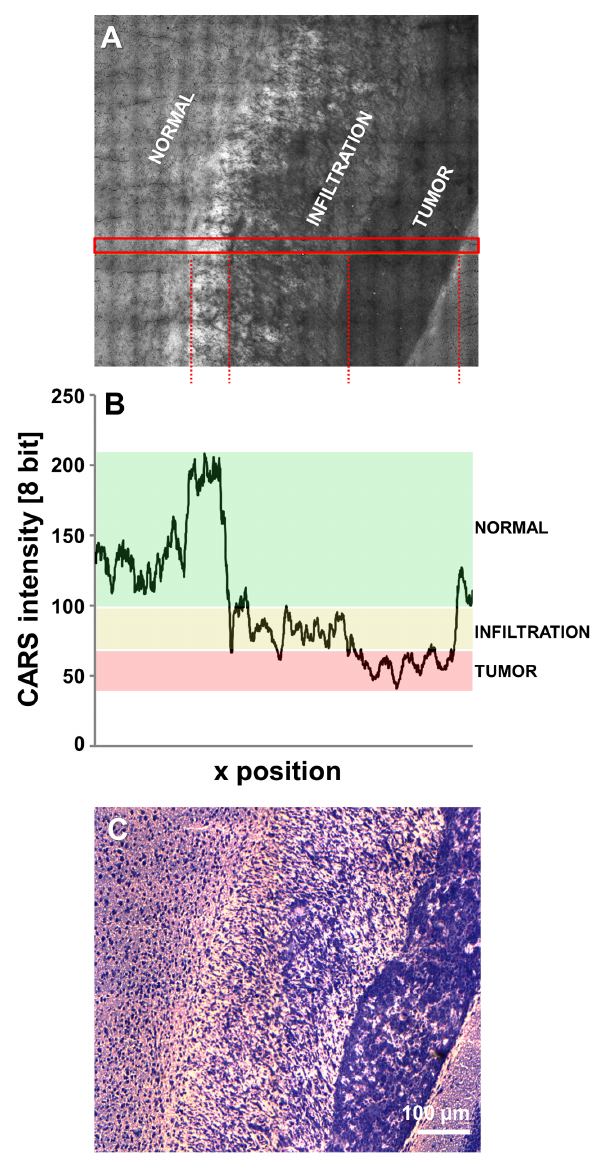
Figure 3. Quantification of the CARS signal intensity of infiltrative tumor areas. A : Unprocessed CARS image of a human U87MG glioblastoma in a mouse brain, displaying a solid tumor and a large infiltrative region. B : CARS signal intensity along the area indicated in A. The CARS signal intensity range indicative of normal tissue is underlined in green, the intensity range indicative of infiltrative areas in yellow and the intensity range indicative of tumor in red. C : H&E staining corresponding to